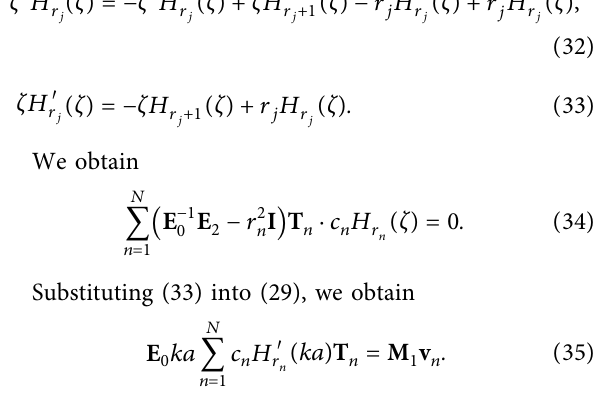
l � 0.2 and c � 0 0